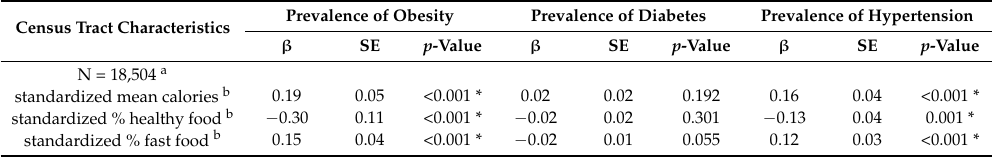
Table 1. Census tract level food environment characteristics and health outcomes (median regression).